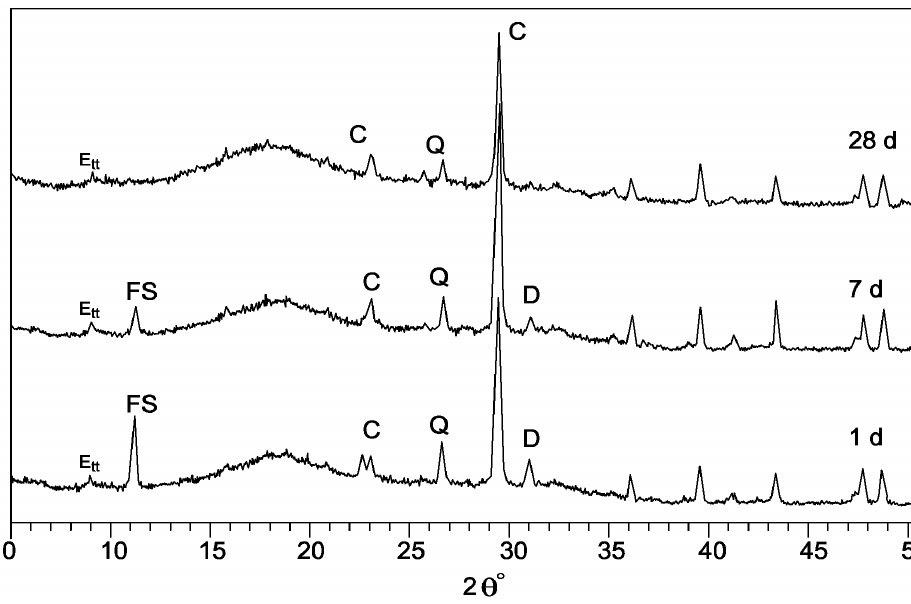
Figure 3. XRD spectra of hydratory system S1.